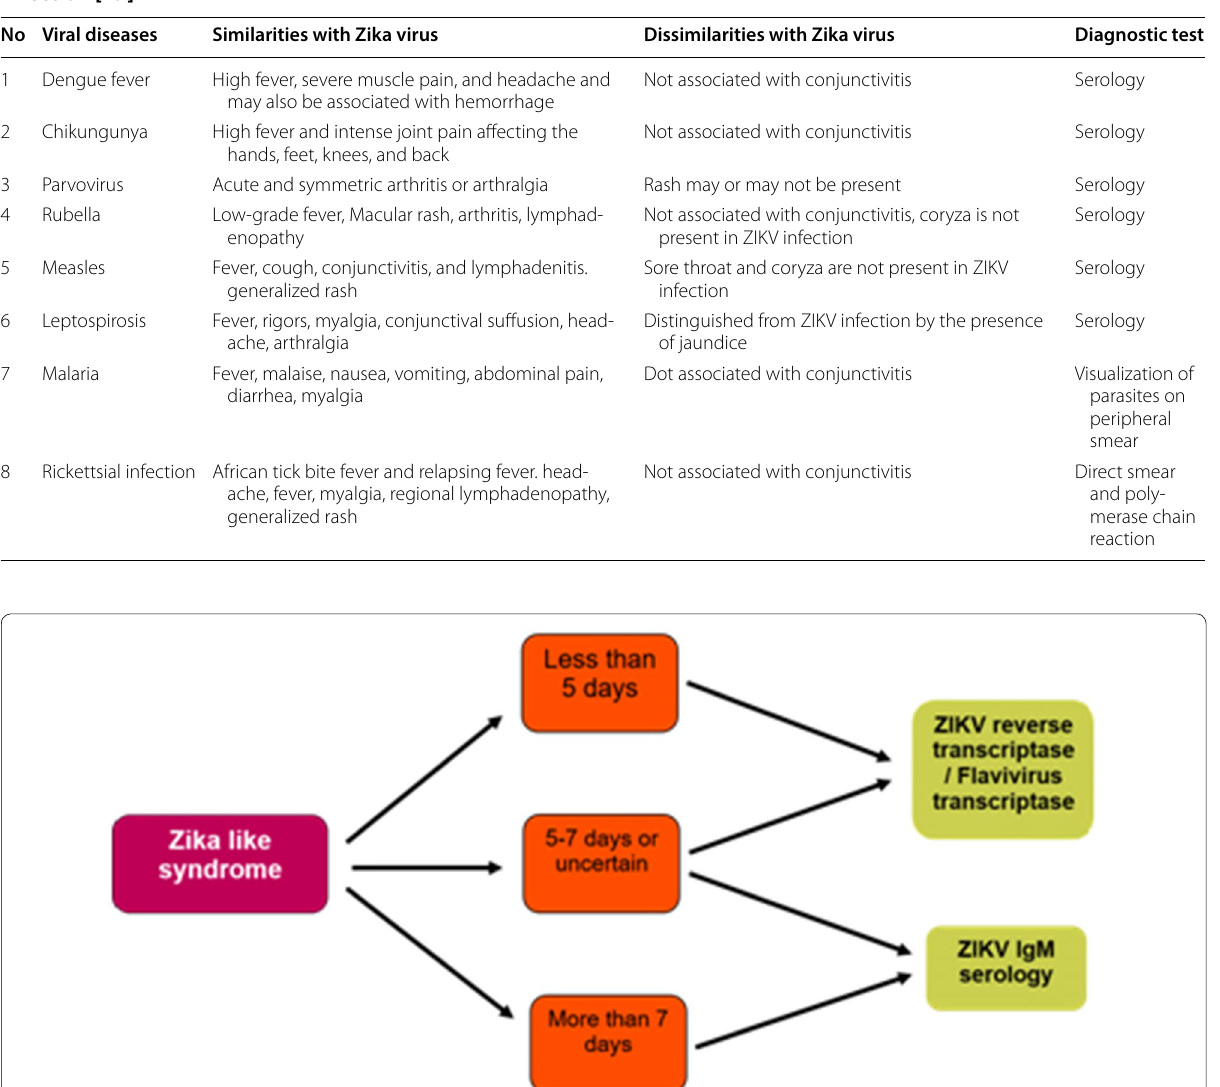
Table 1 Differential diagnosis of ZIKV infection includes various viral diseases with similar signs and symptoms as ZIKV